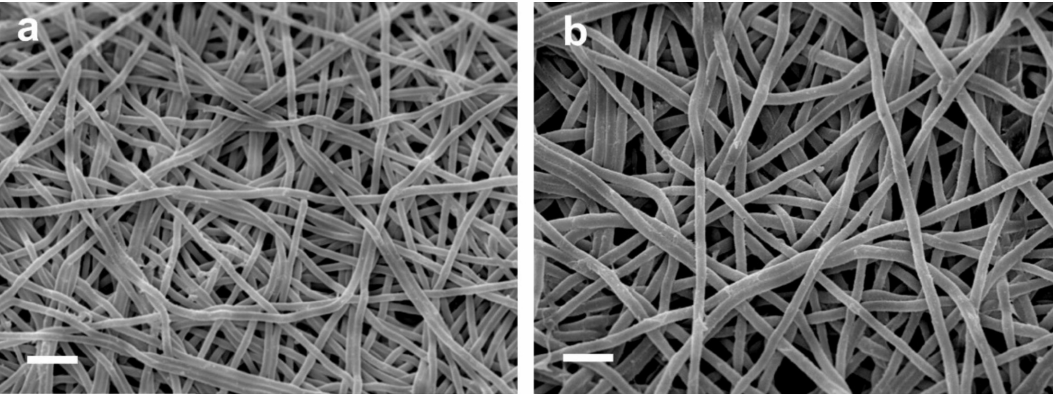
Figure 9. SEM images of nanofiber mats crosslinked by genipin, followed by PBS rinsing, spun from ( a ) gelatin; ( b ) gelatin/genipin, after 7 days immersion in DMEM. Scale bars depict 5 µ m. Reprinted from [106]. Copyright 2021